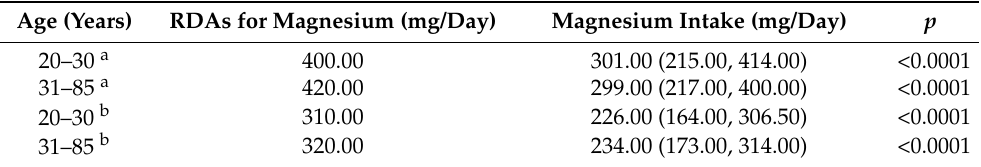
Table 1. Magnesium intake among United States (US) adults (>19 years) in NHANES